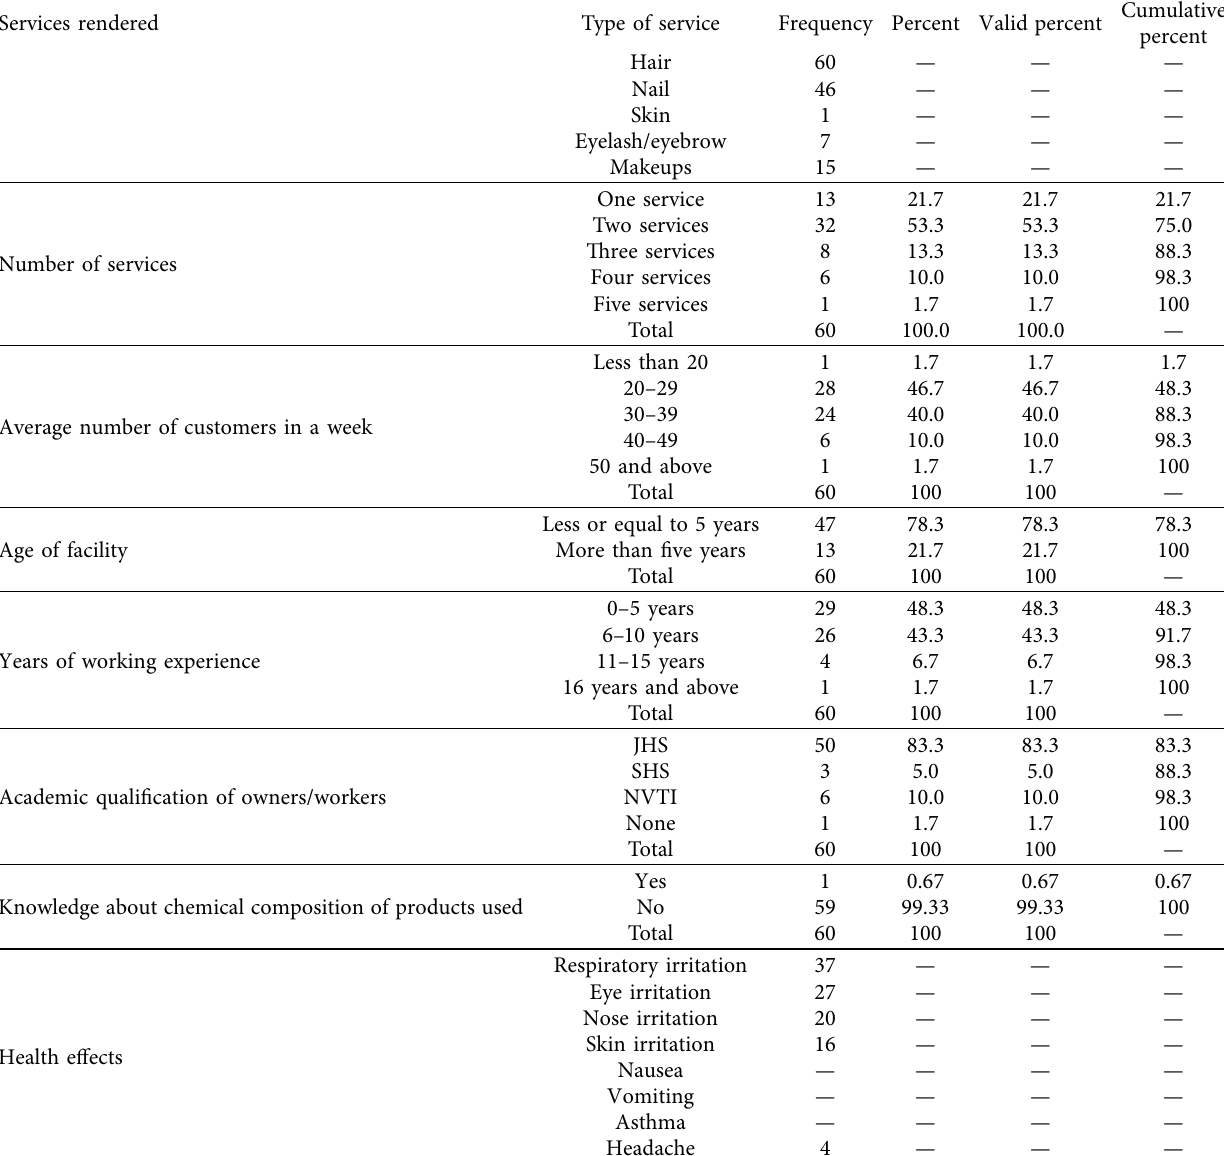
Table 2: Statistical analysis of independent variables.